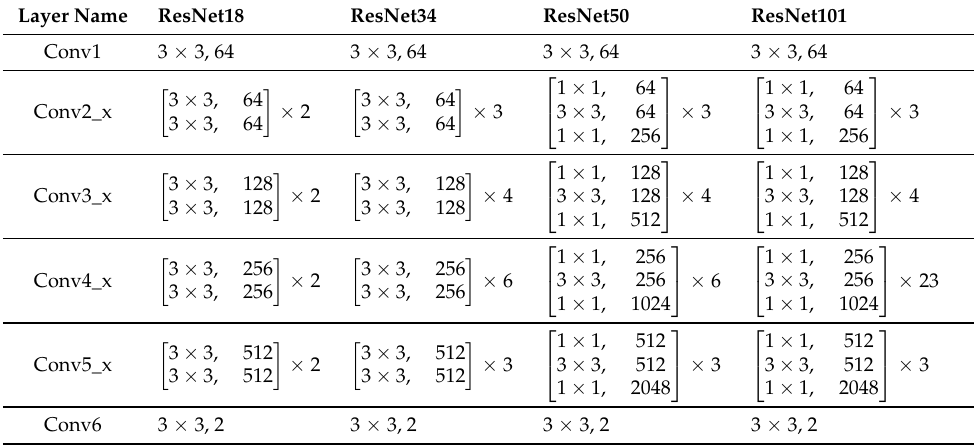
Table 2. Structure of the residual networks.